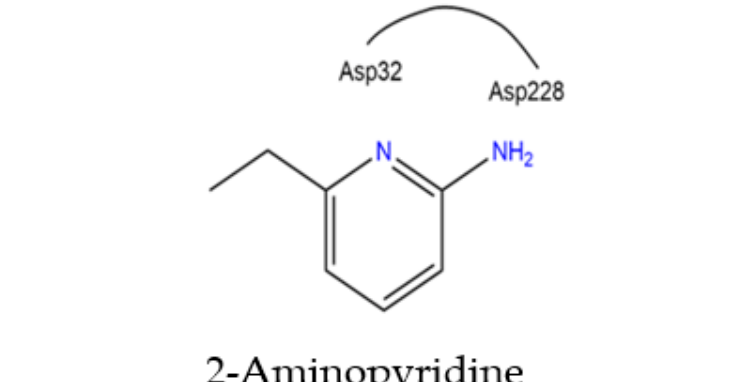
Table 4. Correlation coefficients (R 2 ) of Δ H with contributing energies (from Table 2) for groups of inhibitors.